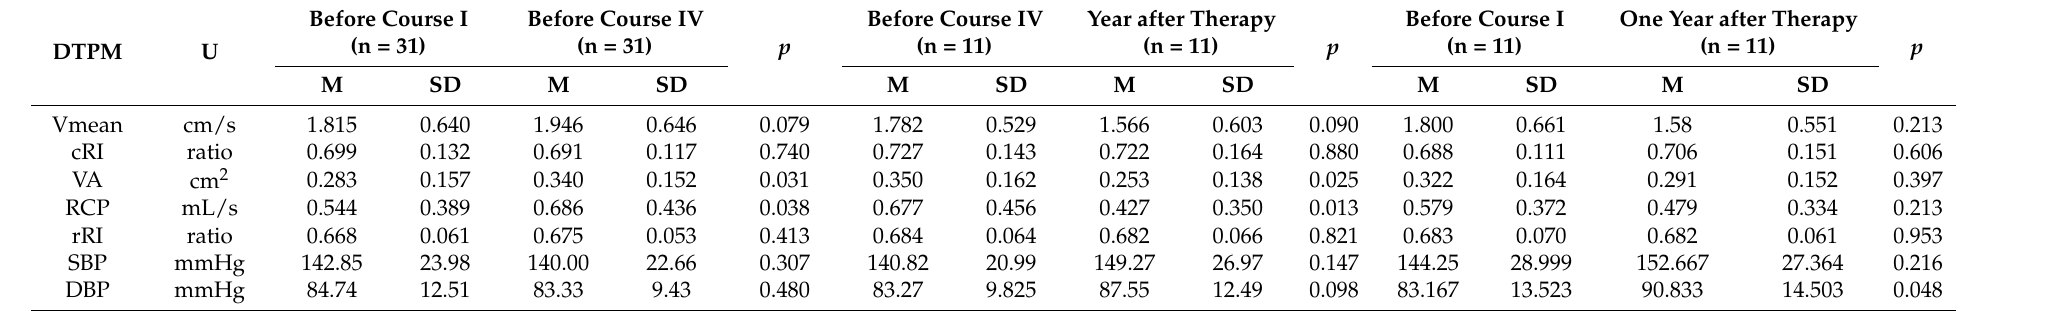
Table 6. Combined dynamic tissue perfusion measurement (DTPM) parameters throughout the